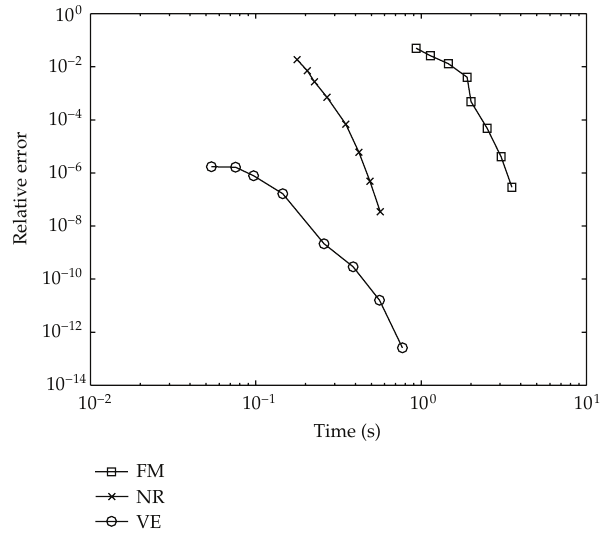
Figure 10: Relative error in N ret versus computation